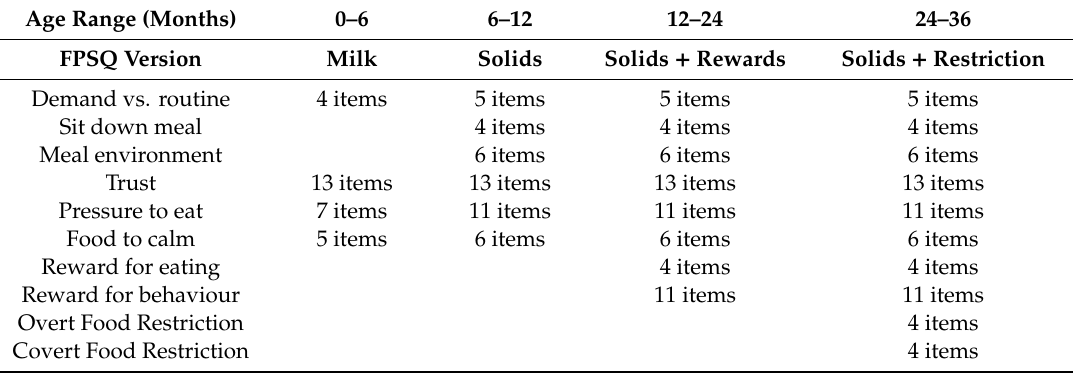
Table 1. PICNIC study feeding practice constructs and age range. FSPQ: Feeding Practices and Structure